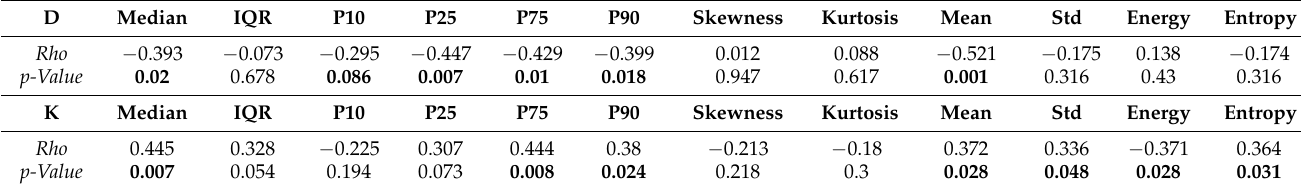
Table 3. Correlation coefficients between the DKI-derived parameters and TILs.